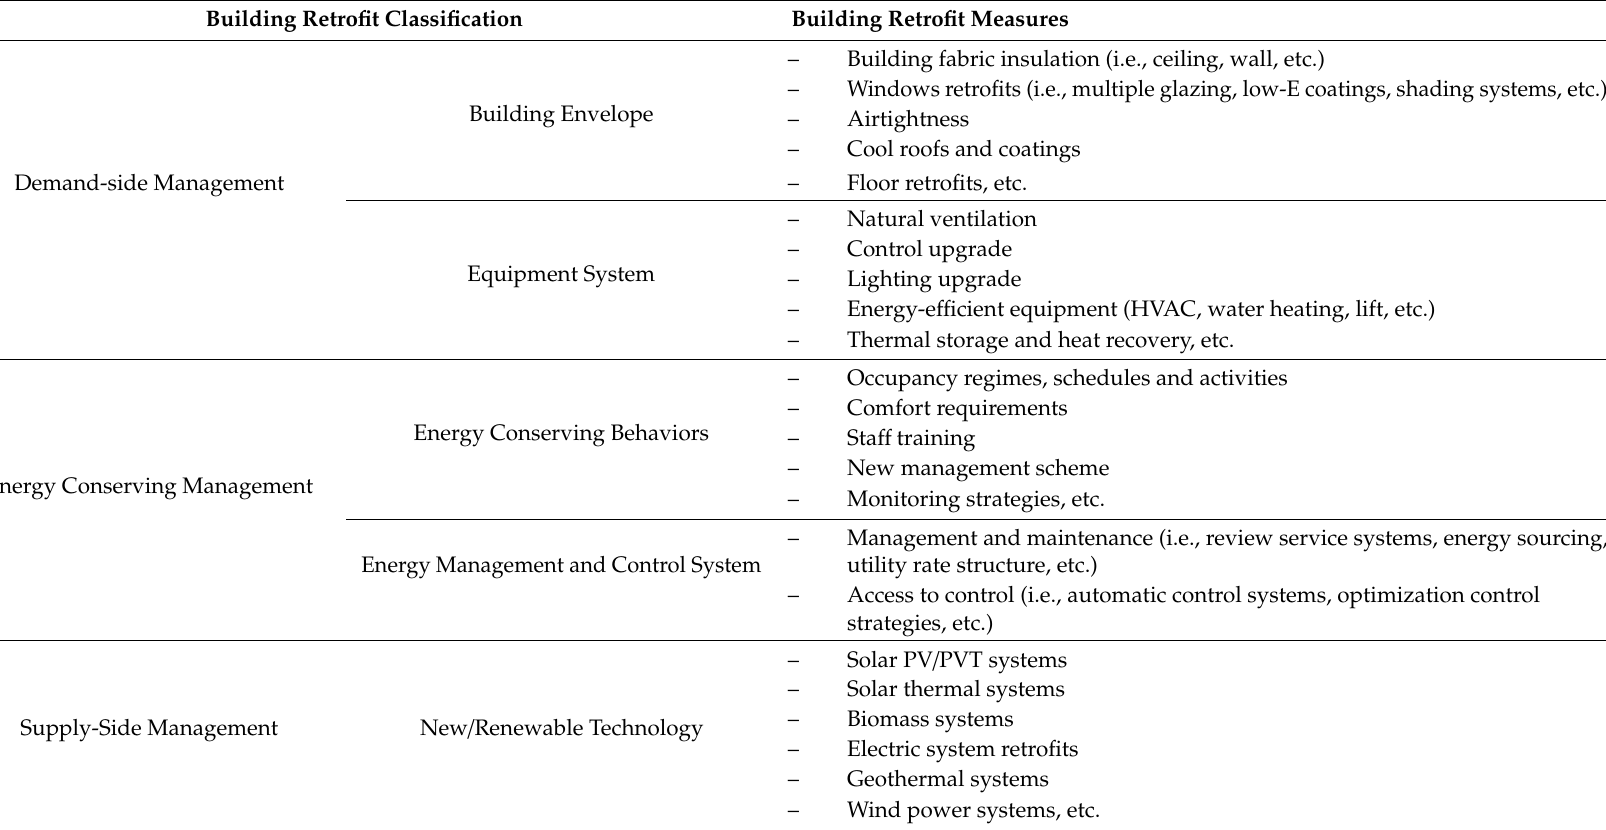
Table 3. General building retrofit measures and classification (Adopted from [16])